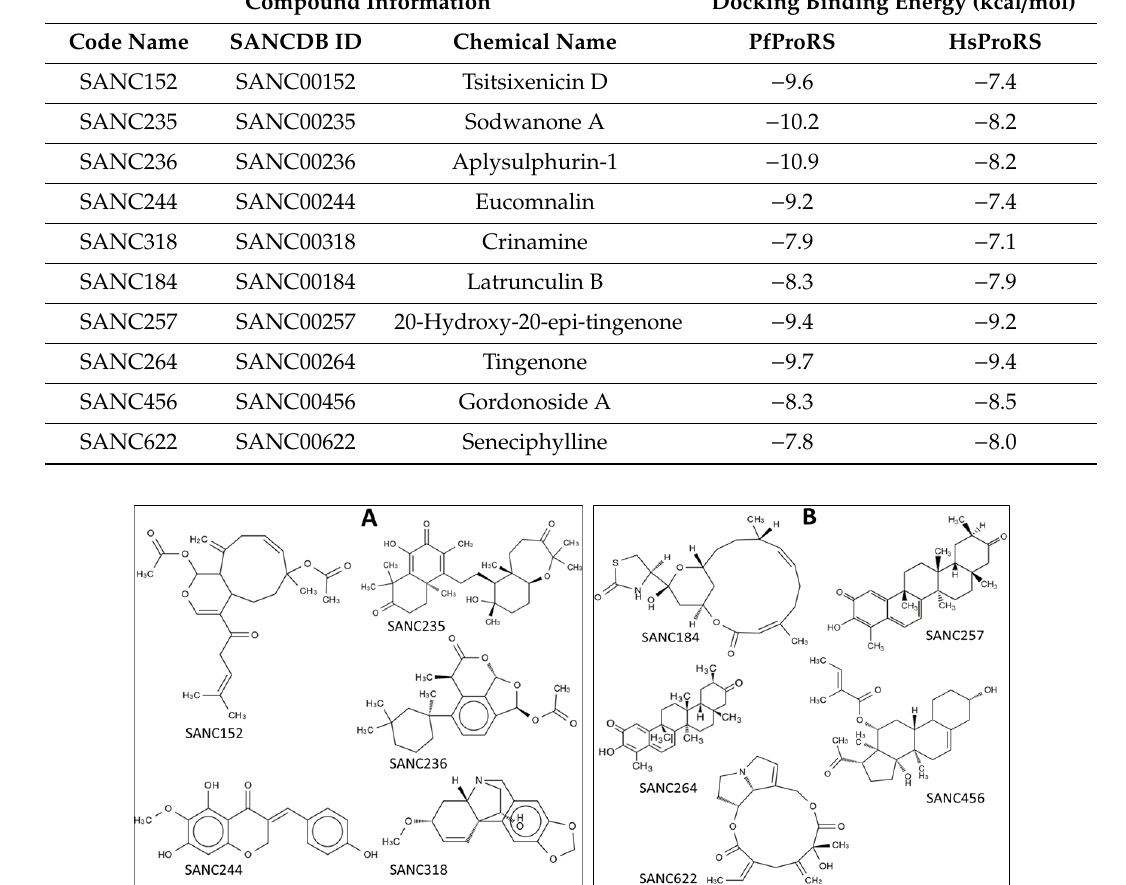
Table 1. South African natural compound hits and docking binding energy information.